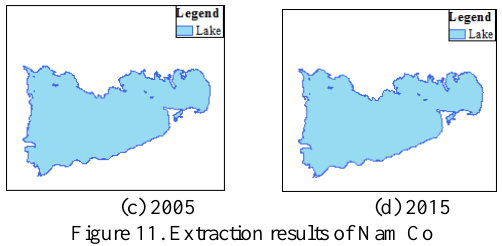
Figure 11. Extraction results of Nam Co